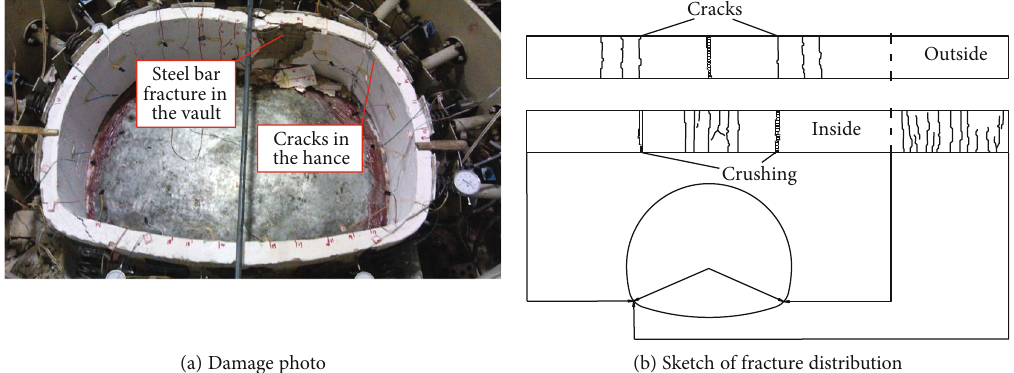
Figure 5: Damage form of the lining under condition